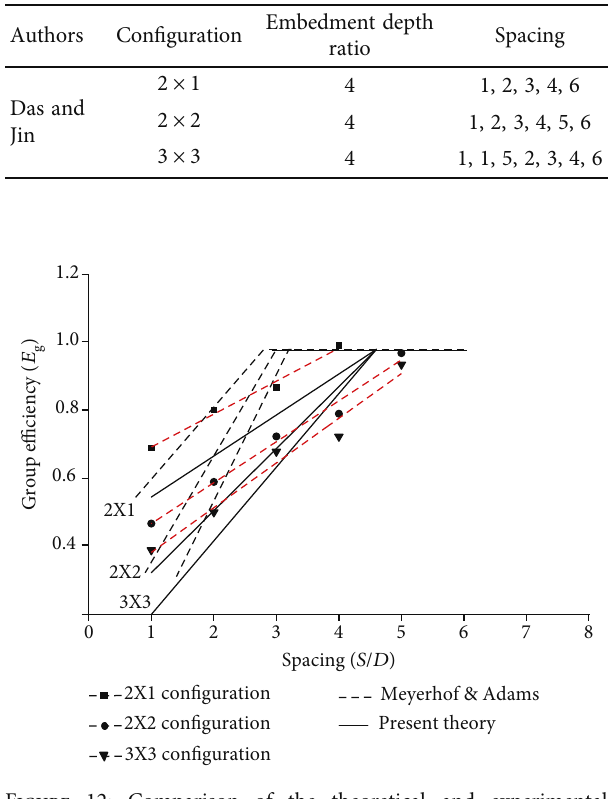
Figure 12: Comparison of the theoretical and experimental variation of group e ffi ciency. Table 4: Sand properties for group anchor tests.